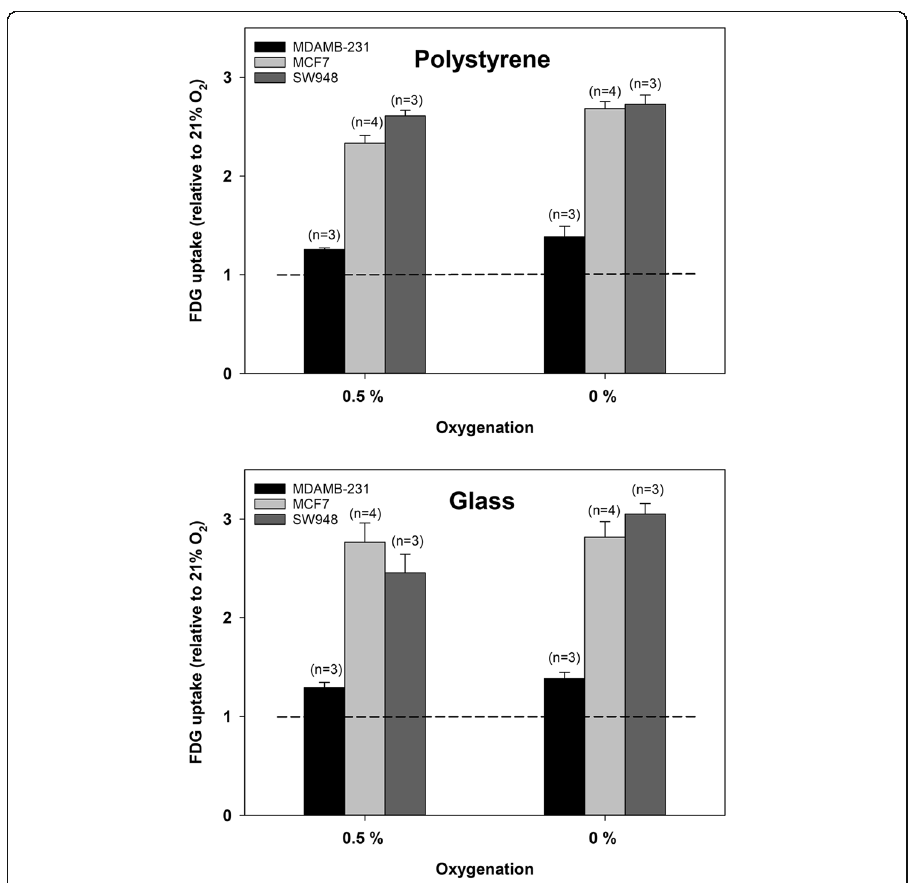
Fig. 3 Oxygenation-dependent [ 18 F] FDG uptake and its dependency on plating material using orbital shaking in a further panel of cell lines. Values are means (± SEM). The number of independent experiments for each condition is given in